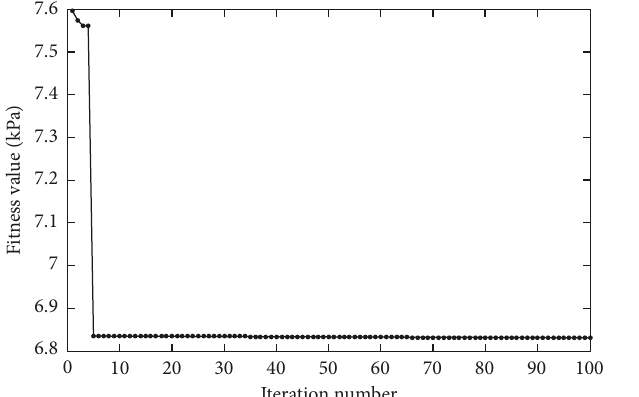
Figure 3: Convergence graphic of the training process.